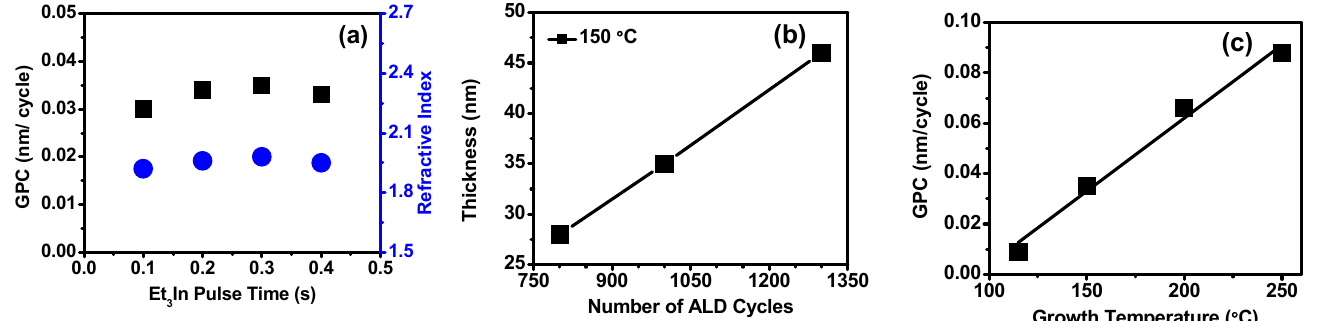
Figure 1. ( a ) The variation in the growth rate ( ■ ) and refractive index ( ● ) of In 2 O 3 films as a function of the Et 3 In precursor pulse time at 150 °C ( b ) In 2 O 3 film thickness as a function of the number of ALD cycles for the film deposited at 150 °C on the Si substrate ( c ) Variation in In 2 O 3 film GPC at various growth temperatures.